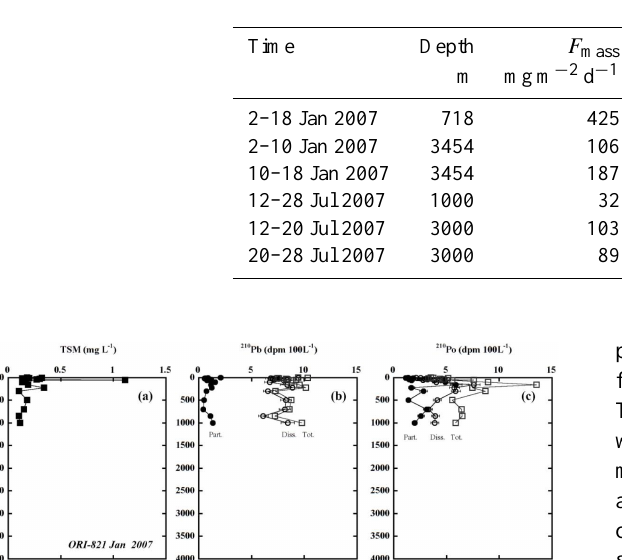
Table 1. Fluxes of total mass ( F mass ) , 210 Pb ( F Pb − 210 ) , and 210 Po ( F Po − 210 ) measured by sediment trap. Standard deviations of radionuclide data are based on propagated counting error (1 σ ).